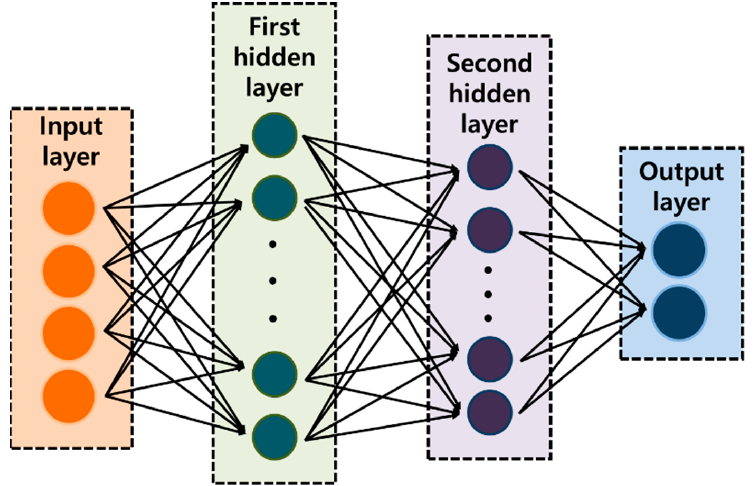
Figure 4. ANN architecture for identification of debonding damage.